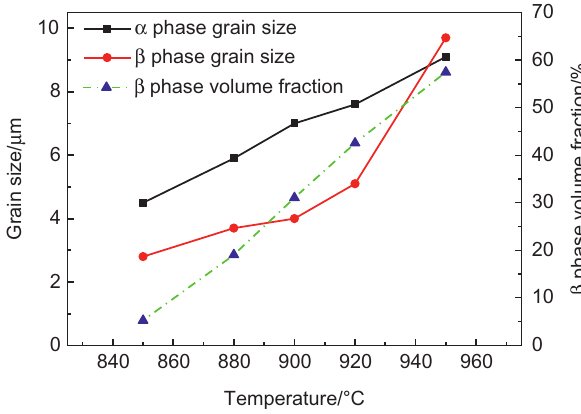
Figure 6: The phase grain sizes and β phase volume fraction of specimens at various